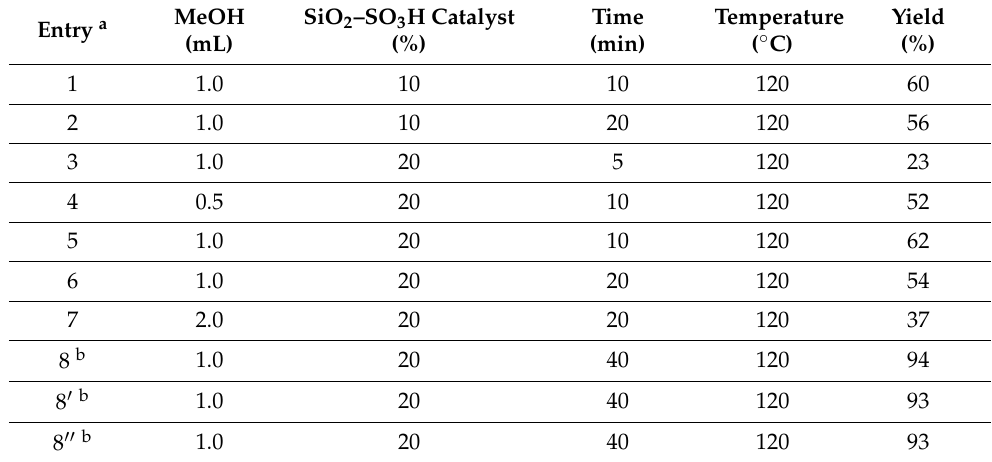
Table 1. The experimental results obtained for the transesterification–esterification of ASA.